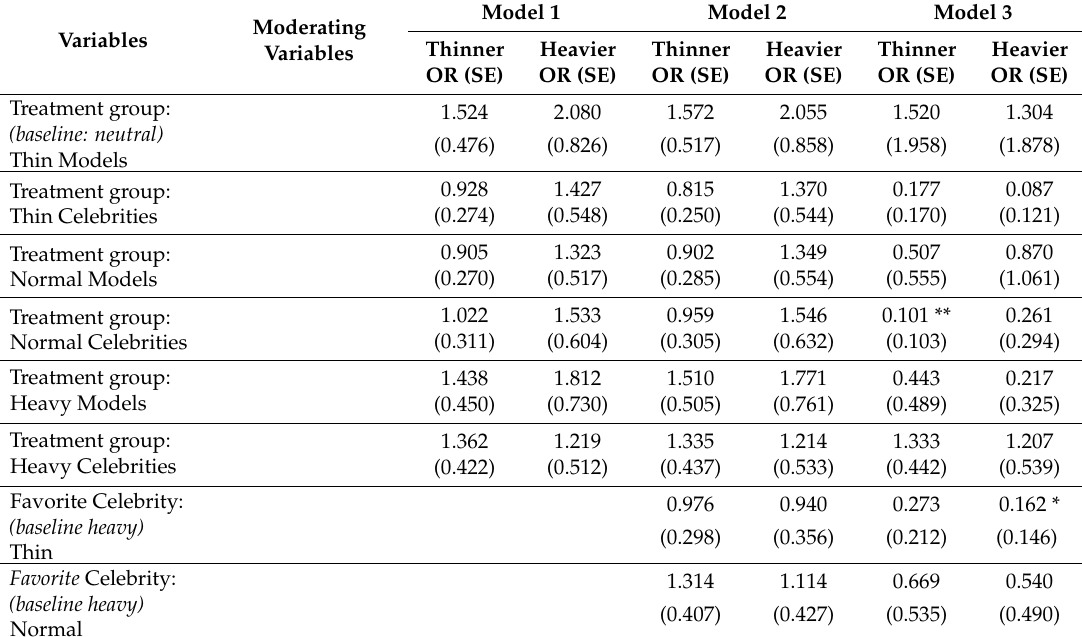
Table 3. Multinomial Logistic Models of Body Size Change with and without Interactive